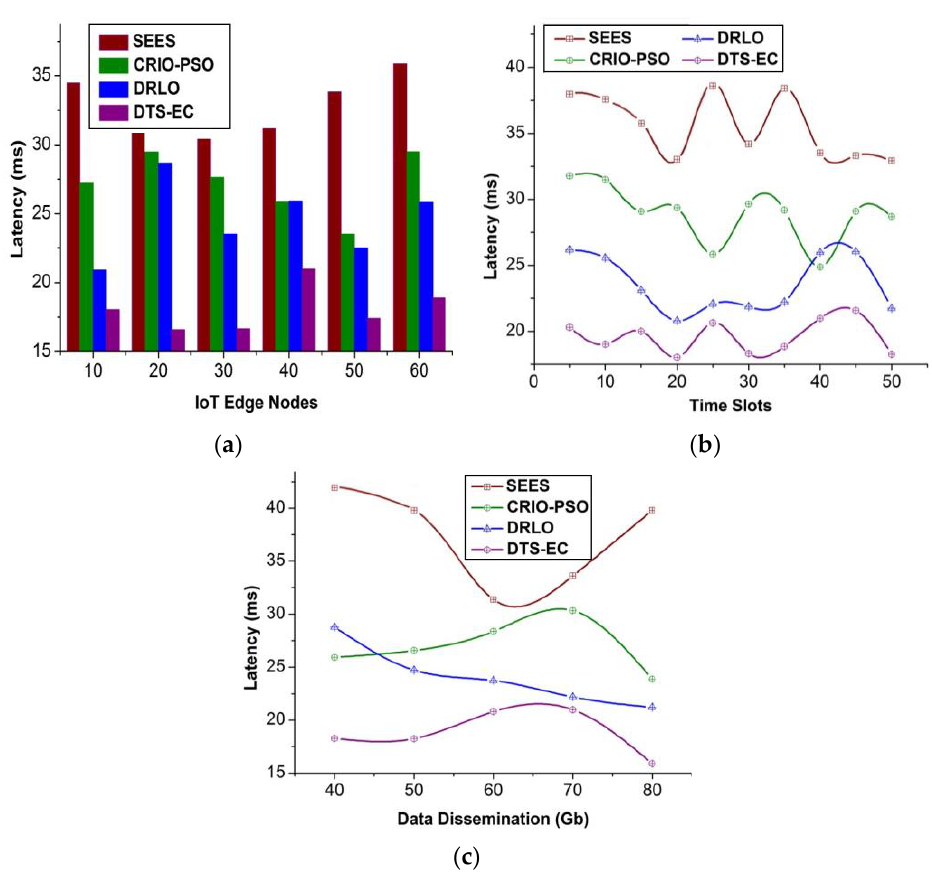
Figure 8. Latency Comparisons for ( a ) IoT edge nodes, ( b ) time slots, and ( c ) data dissemination.